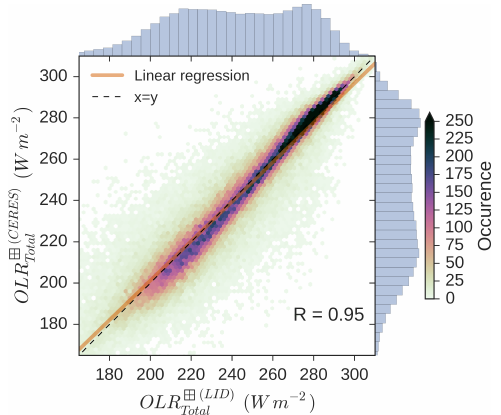
Figure C1. Comparison between observed and lidar-derived OLR on a monthly mean 2 ◦ × 2 ◦ gridded scale. Only nighttime condi- tions over ice-free oceans for the year 2008 are